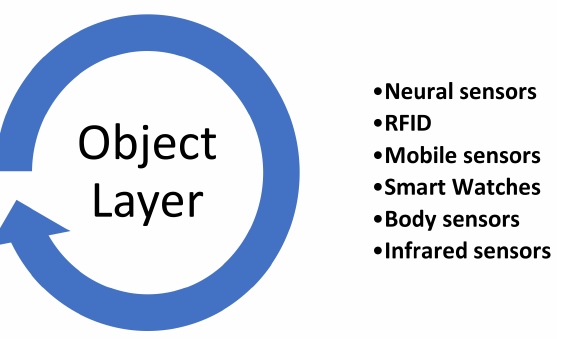
Figure 5. Object